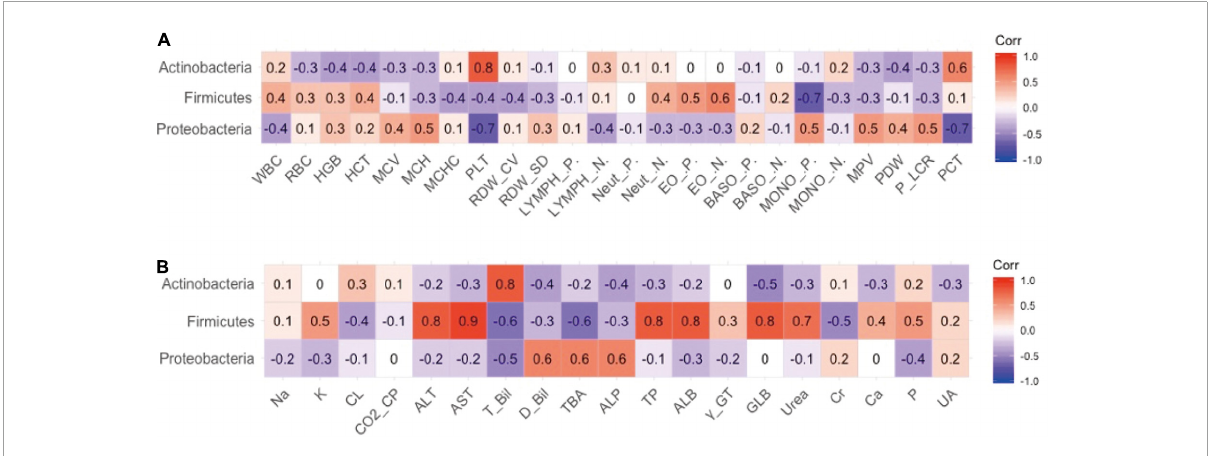
FIGURE2 The relevance between phylum level of intestinal flora and secondary clinical outcomes. (A) The Pearson correlation coefficient of phylum level of intestinal flora and blood routine indicators. (B) The Pearson correlation coefficient of phylum level of intestinal flora and blood biochemistry